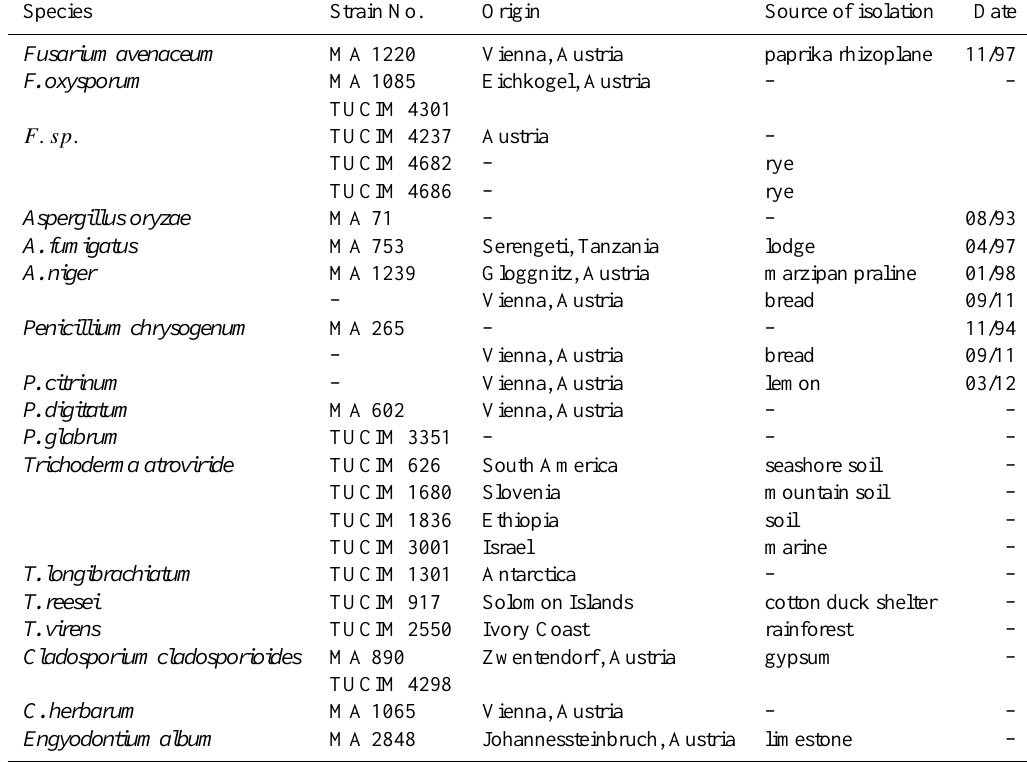
Table 1. Origin and properties of studied